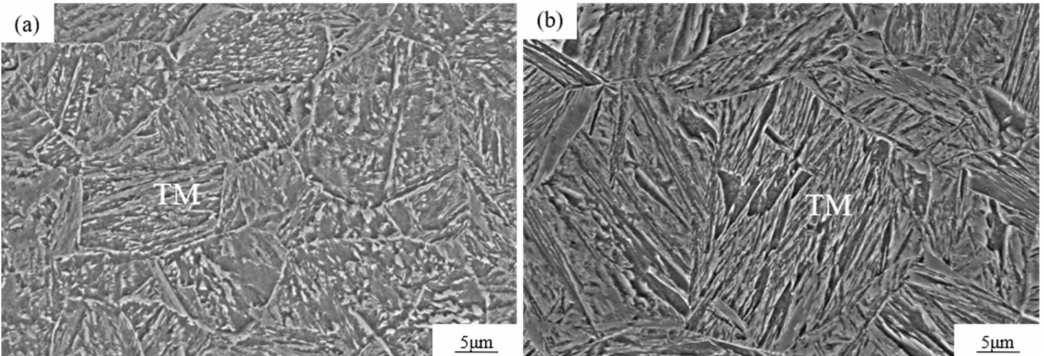
Figure 6. Microstructures of steel A ( a ) and steel B ( b ) heated at 880 ◦ C for 3min then soaked at 200 ◦ C for 30 min during air cooling.